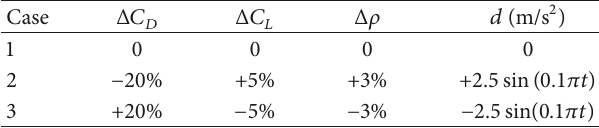
Table 1: Parameter uncertainties of different cases. Table 2: Control